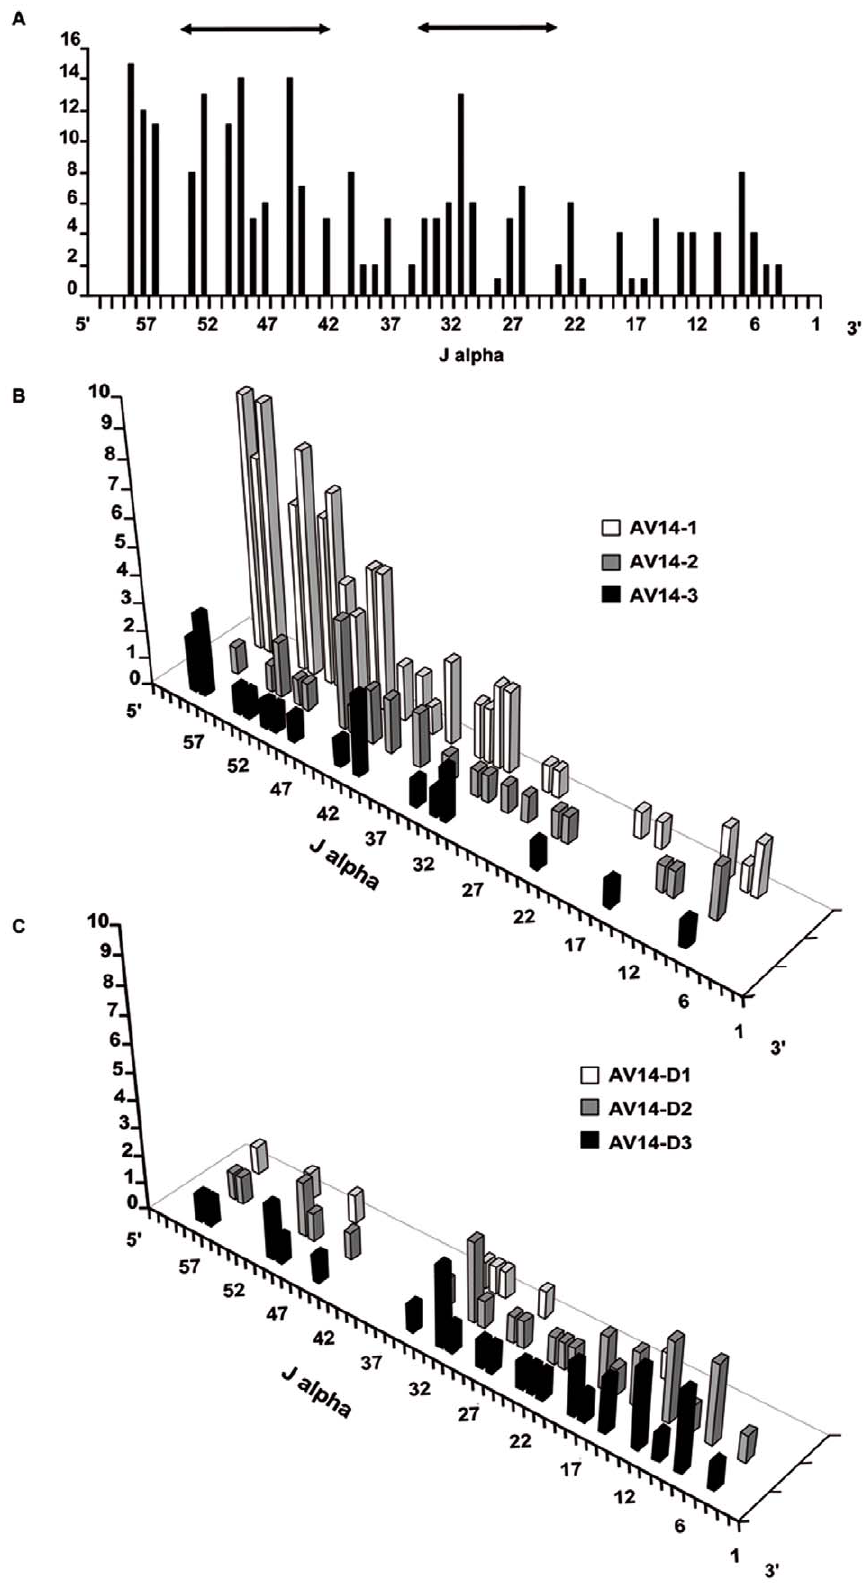
Figure 1. Quantification of the J region use by the V14 family. 254 V14 rearrangements were cloned from T lymphocytes, the V14 members and J genes were determined by sequencing [10]. (A) Profile of the J use by the six members of the V14 family. The two arrows indicate the localization of the two Hot Spots. (B) Profile of the three members the nearest from J genes and (C) J use by the most 5 9 V14 members.